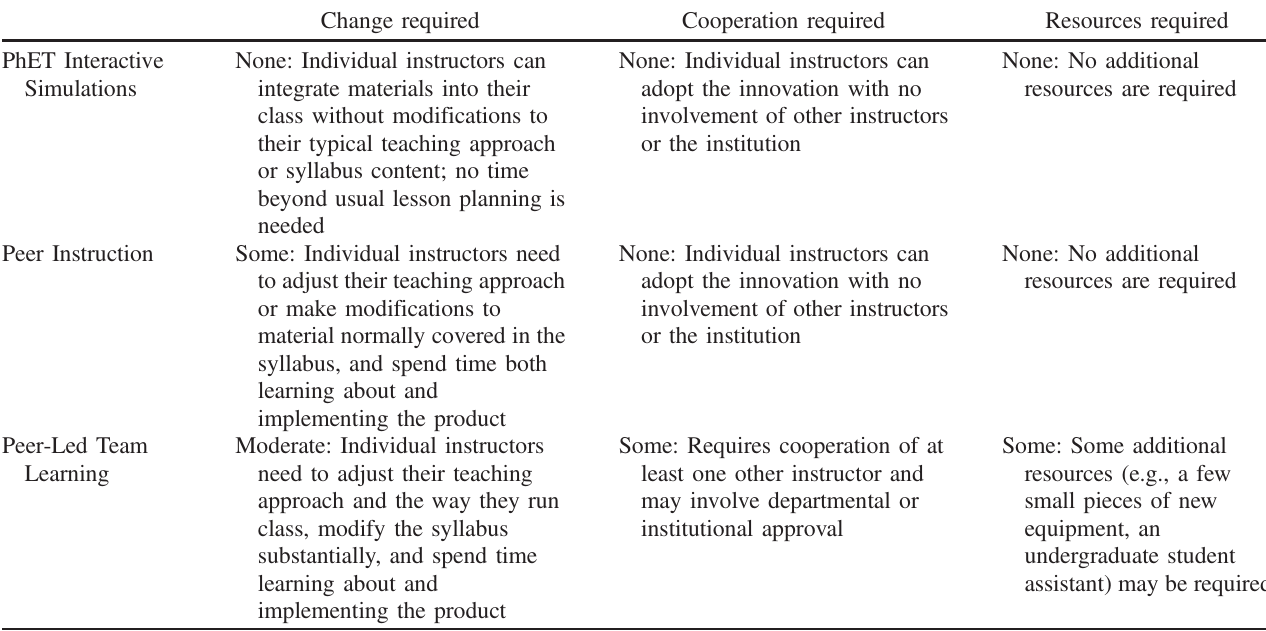
TABLE II. Descriptions of the types of change required of potential adopters to adopt the three cases discussed. Change required Cooperation required Resources